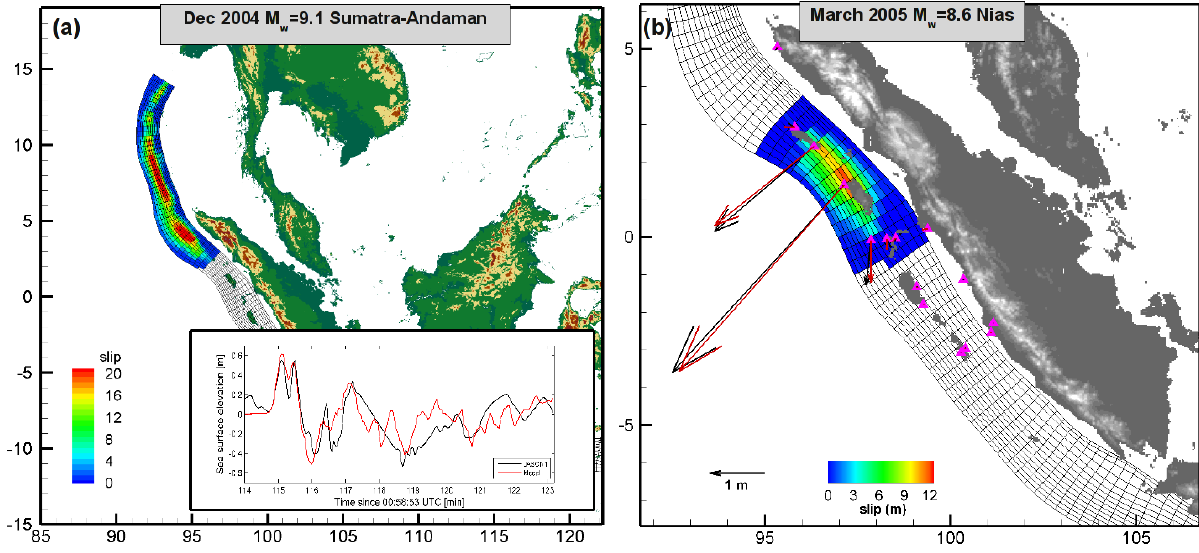
Fig. 3. Source models for the two historical events off Sumatra. Slip distribution was inverted from GPS observations. (a) Model for the Great Sumatra-Andaman M w =9.3 earthquake (Hoechner et al., 2008). Inlet shows comparison of the corresponding tsunami propagation model with the direct tsunami observation in Indian Ocean some two hours after the earthquake by the Jason-1 satellite mission. (b) 2005 Nias-Simeulue M w =8.6 event.